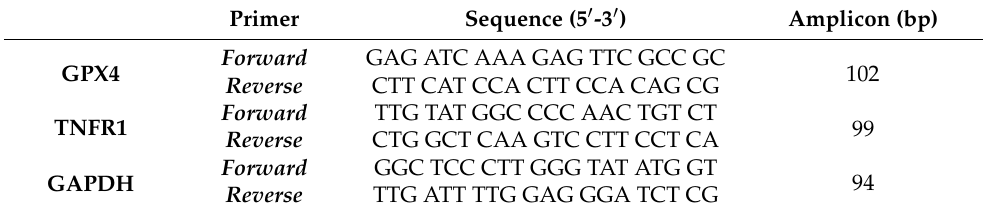
Table 1. Oligonucleotide sequences of the primers used for RT-qPCR.